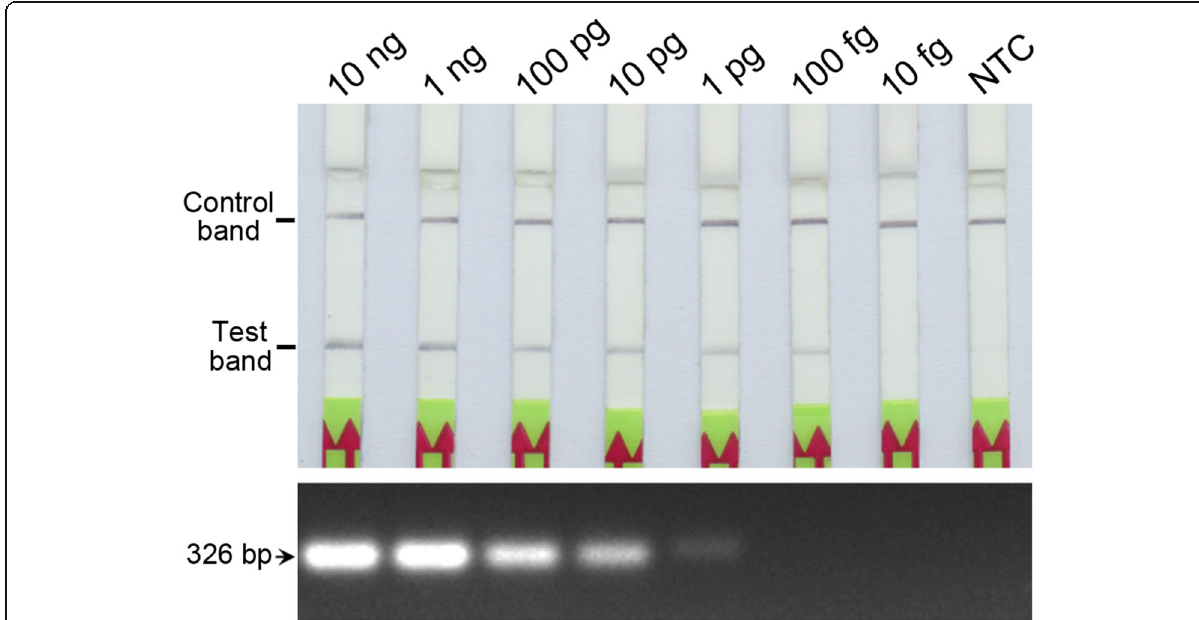
Fig. 2 Comparison of the sensitivity of the LF-RPA assay (upper panel) and conventional polymerase chain reaction (PCR; lower panel) for P. cactorum detection. Serial dilutions of P. cactorum genomic DNA were used to evaluate the detection limit. NTC, no-template control. At least three replicate tests were performed